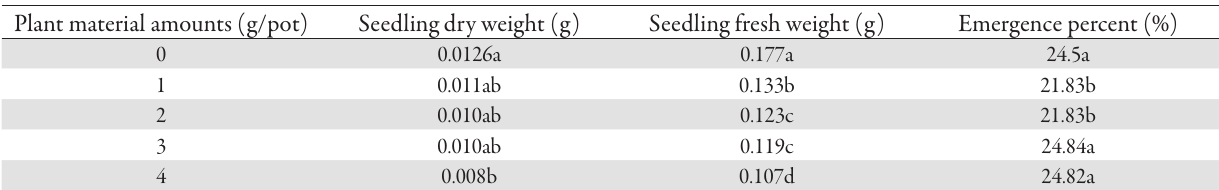
Tab. 2. Means comparison of seedling emergence, seedling dry and fresh weight of Amaranthus retroflexus under varying amounts of Russian knapweed plant material Plant material amounts